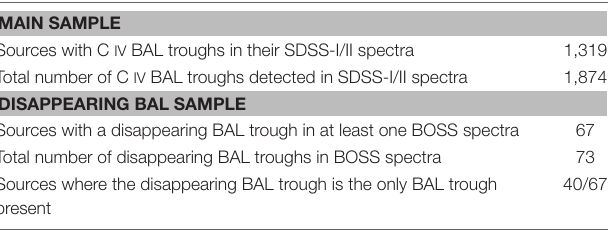
TABLE 1 | Detailed information about our main sample of sources and the sample of C IV disappearing BAL troughs. MAIN SAMPLE